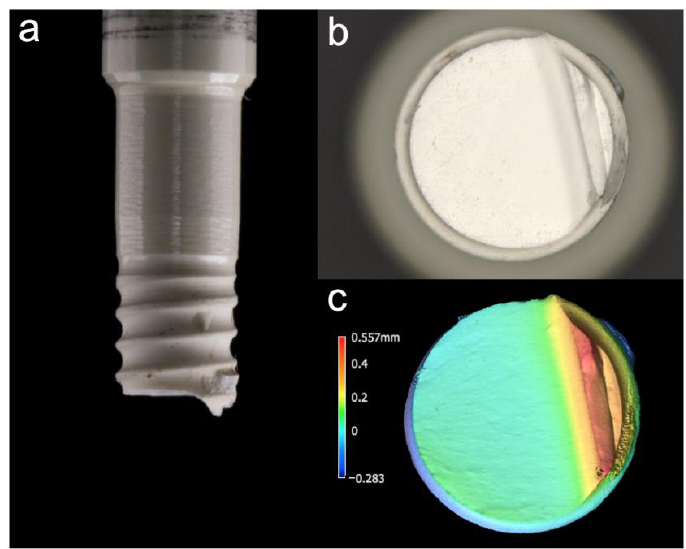
Figure 7. ( a ) Exemplary fracture evaluation of the Ce-TZP-comp implants: Side view of a smooth horizontal fracture in combination with a compression curl facing apically, ( b ) apical view of the fracture area (40× magnification), ( c ) profile analysis after digitization with a 3D profilometer (VR-500, Keyence, Osaka, Japan).